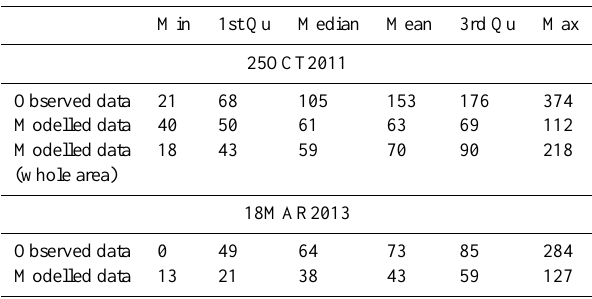
Table 3. Descriptive statistics of the observed and modelled 24h rainfall amounts for both study cases (unit is mm).